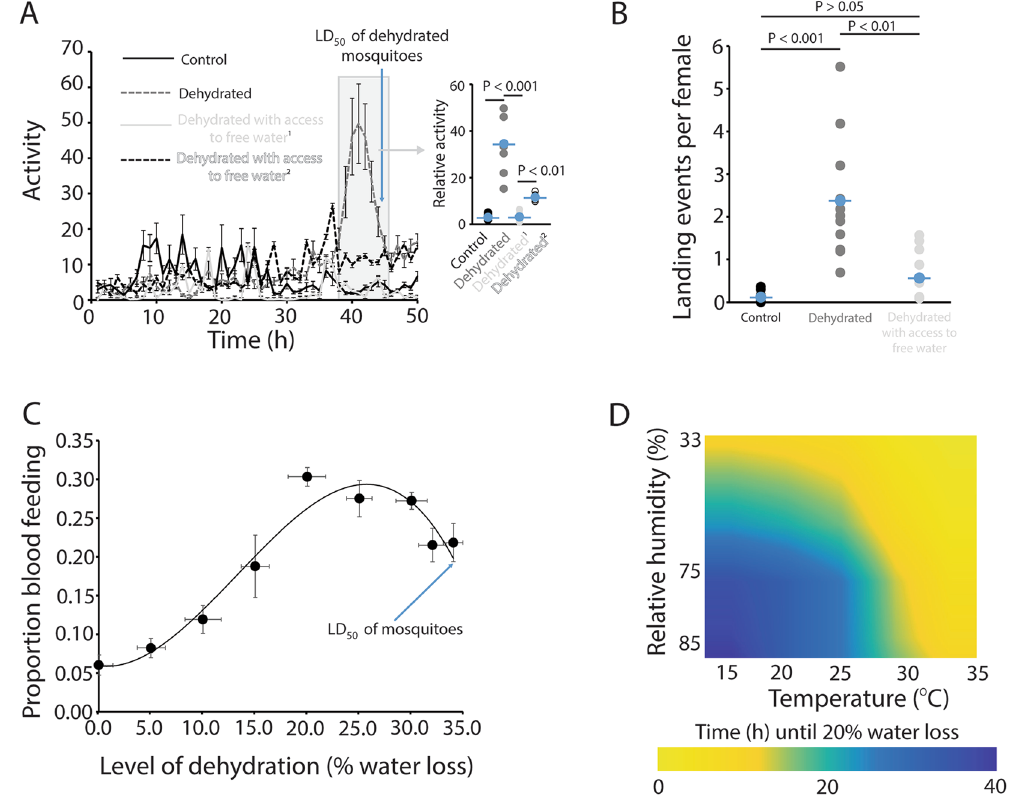
Figure 1. Dehydration increased mosquito activity and blood feeding for C . pipiens females. ( A ) Activity measured by a Locomotor Activity Monitor 25 (LAM25) system through the course of dehydration, inset represents averaged results from 38–44 hours. Each point is the mean ± SE of 36–48 mosquitoes. 1 Mosquitoes have access to water for drinking to remain hydrated. 2 Free water is present, but mosquitoes are prevented from drinking by a mesh barrier. ( B ) Number of landing events per mosquito over the course of one hour. Mean ± SE represents 12 independent replicates of 30–40 mosquitoes. ( C ) Proportion of mosquitoes following varying levels of dehydration that blood fed within two hours of host availability. Mean ± SE represents 10 replicates of 50 mosquitoes. ( D ) Time until the 20% dehydration point under varying temperatures and relative humidity (RH). Three replicates of 40 mosquitoes were conducted at each RH (33, 75, and 100%) at each temperature. Statistical analyses for ( A – D ) were conducted by a t-test or one- and two-way ANOVA followed by Tukey’s HSD post-hoc analysis where